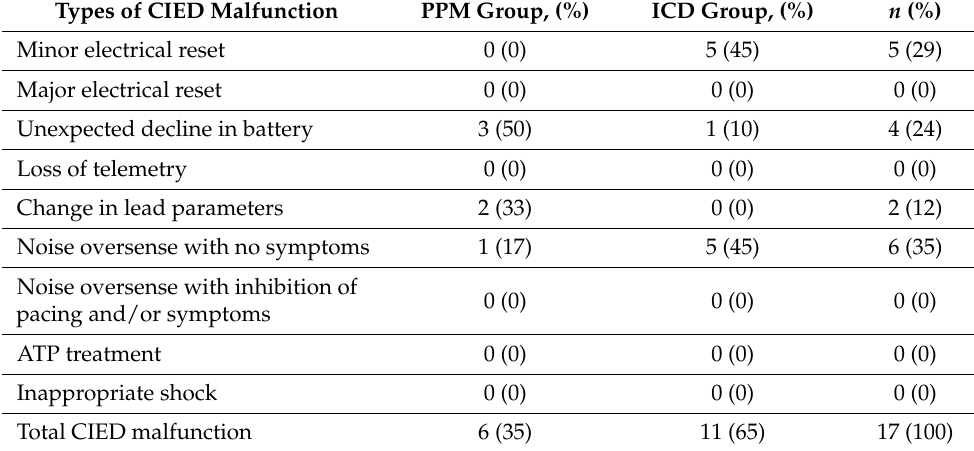
Table 2. Types of CIED malfunction detected in patients who underwent RT. PPM group consists of SC PPM, DC PPM, and CRT–P. ICD group consists of ICD and CRT–D. ATP, antitachycardia pacing; CIED, cardiac implantable electronic device; CRT–P, cardiac resynchronization therapy pacemaker; CRT–D; cardiac resynchronization therapy defibrillator; DC PPM, dual chamber permanent pacemaker; ICD, implantable cardioverter defibrillator; SC PPM, single chamber permanent pacemaker.